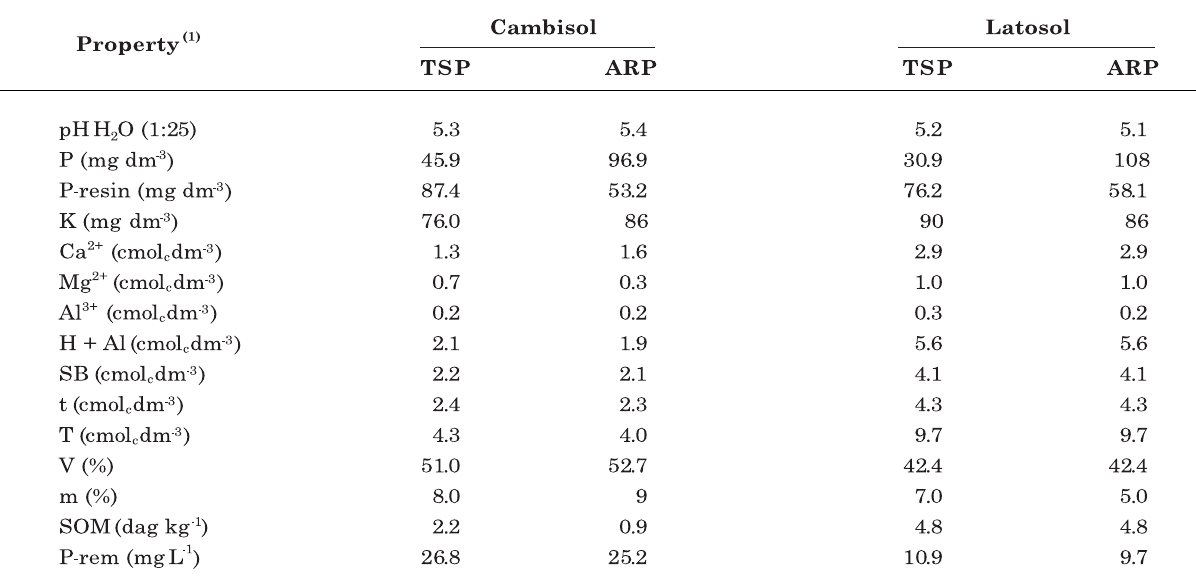
(1) P and K: Extractant Mehlich-1; Ca 2+ , Mg 2+ and Al 3+ : Extractant KCl 1 mol L -1 H + Al–SMP Method; SB: Sum of bases; (t): effective CEC; (T): CEC potential (a pH 7.0); V: base saturation; m: aluminum saturation; SOM: oxidation of Na 0.67 mol L -1 +